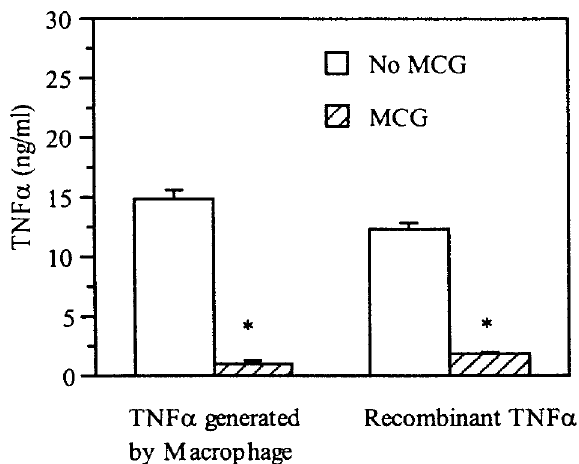
FIG. 6. TNF a degradation by MCG. Macrophage derived and recombinant TNF a were incubated with MCG (100,000 mast cell equivalent) in a volume of 0.2ml culture medium for 24h. TNF a was assayed by ELISA. Values presented are the mean ± SEM of quadruplicate determinations. This is a representative of four experiments.* P <0.05 vs. no MCG.